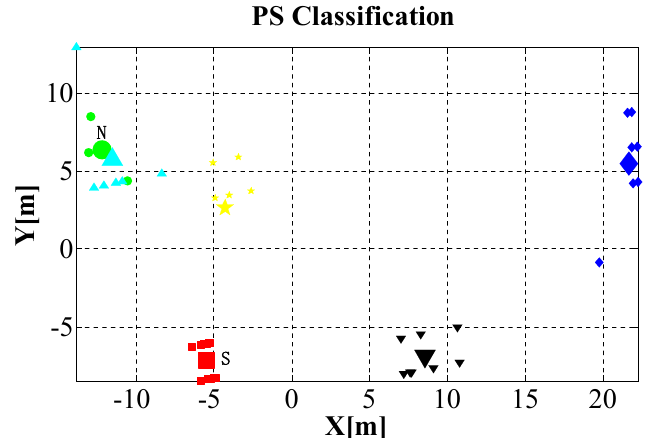
Figure 3. COSMO ‐ SkyMed persistent scatterer pair (PSP) InSAR measurements obtained in the considered area of Foshan, China. Figure 4 shows the PSs selected over the target building (small points) and the convergence points obtained from them (big points). Since pairs of convergence points with similar heights were detected on the building (meaning it is a type III structure), we could compute from the satellite measurements the maximum settlement d max , the maximum differential settlement (cid:1986) (cid:3031),(cid:3040)(cid:3028)(cid:3051) , and the maximum angular distortion β max of the building. The two homogenous PS sets with the largest differential settlement were identified and marked by N (north) and S (south), respectively.